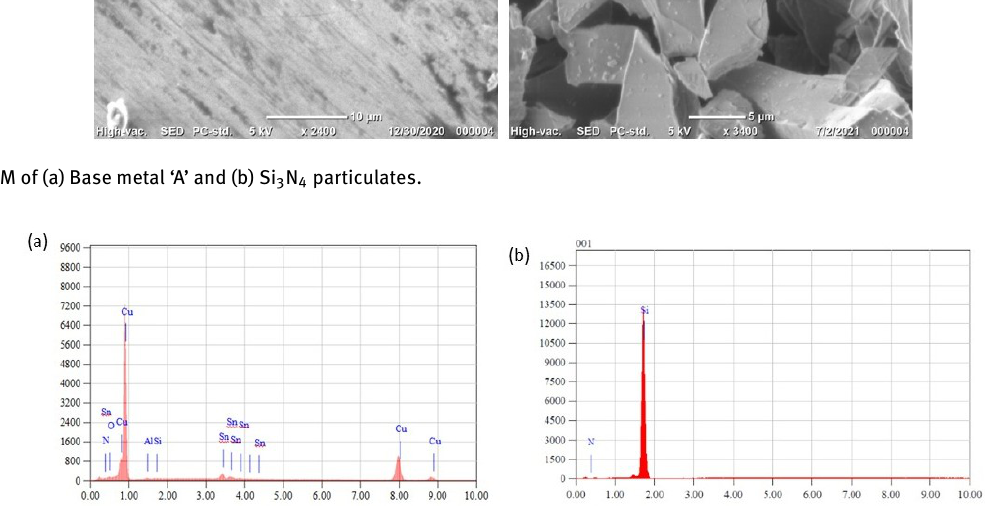
particles were introduced into the matrix and mixed man-